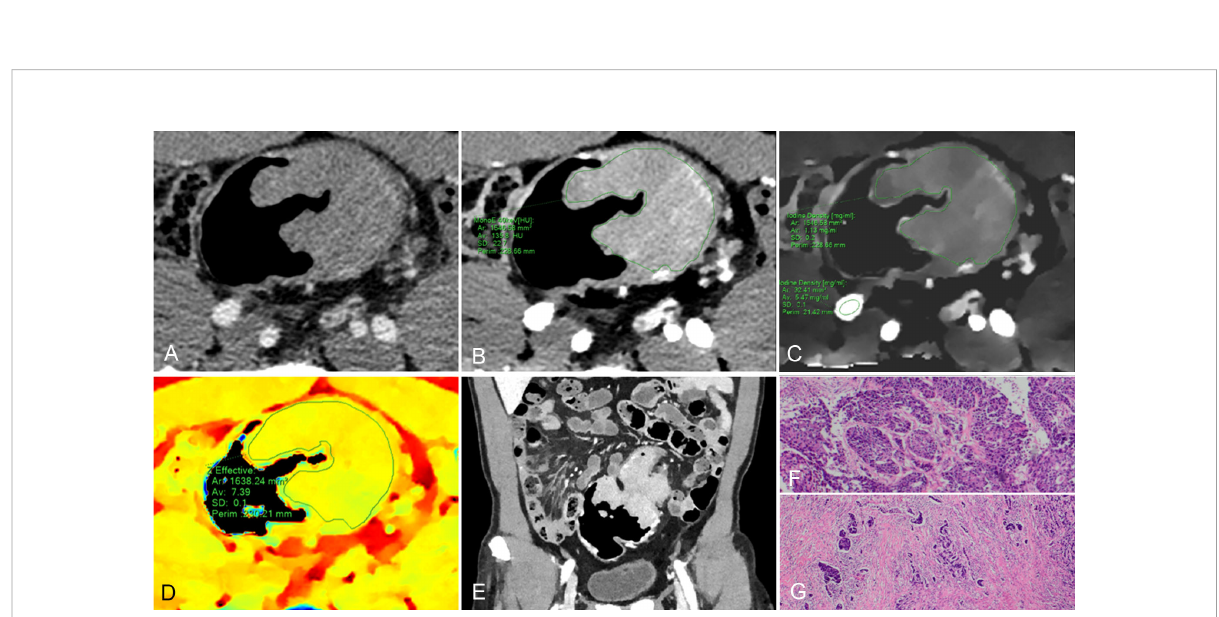
FIGURE 4 61-year-old man with pathological tumor stage 3 and grade 3 colon adenocarcinoma, who underwent preoperative dual-layer spectral- detector CT. (A) Axial arterial phase (AP) contrast-enhanced image shows an irregular mass of the descending colon. (B) 40 keV virtual mono- energetic image (VMI) in AP shows apparent contrast enhancement between the lesion and surrounding tissue. (C) Iodine map in AP shows the lesion with an iodine concentration (IC) value of 1.13 mg/ml; the external iliac artery at the same slice with an IC value of 5.47 mg/ml; a normalized iodine concentration (NIC) value of lesion was 0.21 in AP. (D) Effective atomic number (Eff-Z) images in the pre-contrast phase shows the colorful lesion with an Eff-Z value of 7.39. (E) Coronal reconstruction 40 keV VMI shows the tumor located in descending colon. (F) H E staining demonstrates the tumor with a minor glandular component (×40). (G) The tumor cells invade beyond the muscularis propria